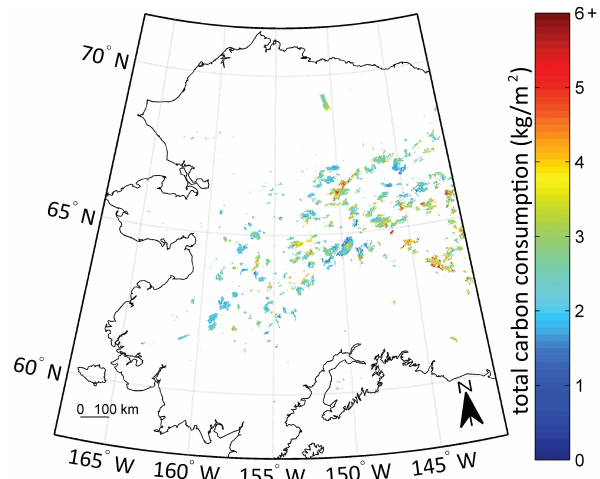
Figure 5. Total pyrogenic carbon consumption estimated from the Alaskan Fire Emissions Database between 2001 and